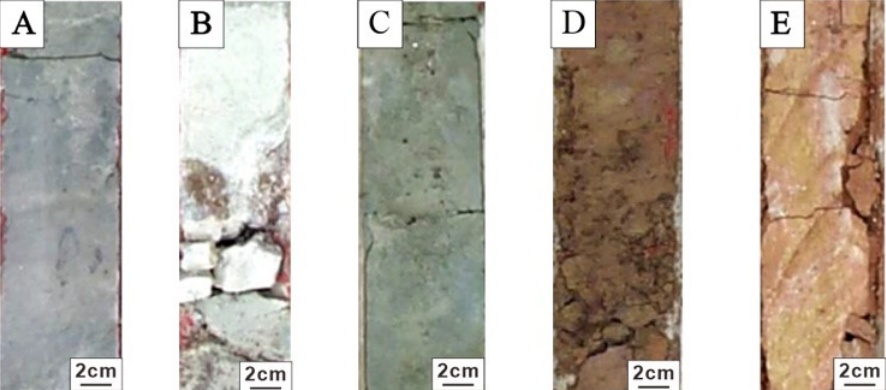
Figure 3. Mudstone color of well PL − 19 − H. ( A ) Gray mudstone, L124, 1713.4 m. ( B ) Light gray mud- stone, L100, 1475.3 m. ( C ) Gray green mudstone, L50, 1180.5 m. ( D ) Brown red mudstone, L70, 1304.6 m. ( E ) Red mudstone, L120, 1574.8 m.